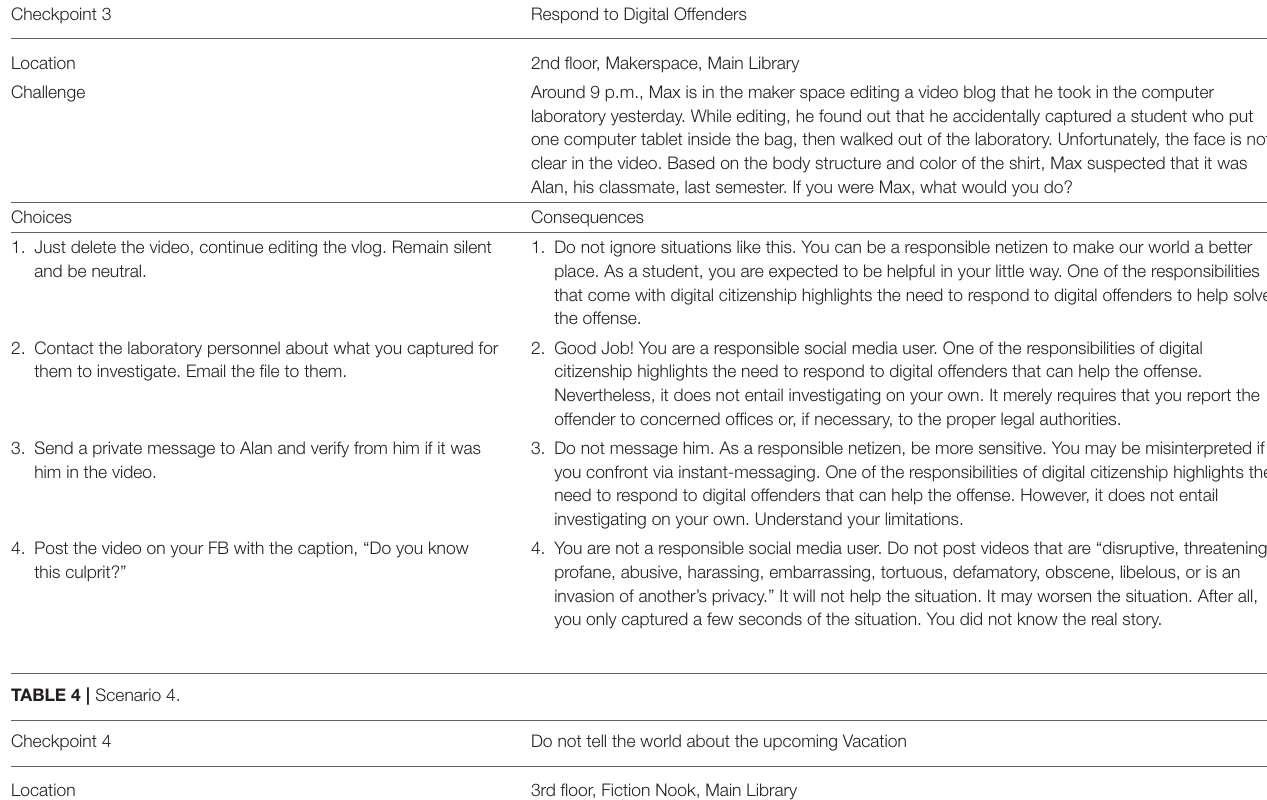
TABLE 3 | Scenario 3. Checkpoint 3